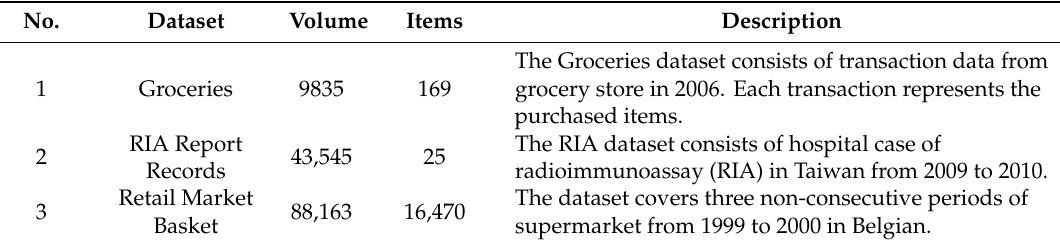
Table 6. Experimental design, dataset attributes and descriptions.